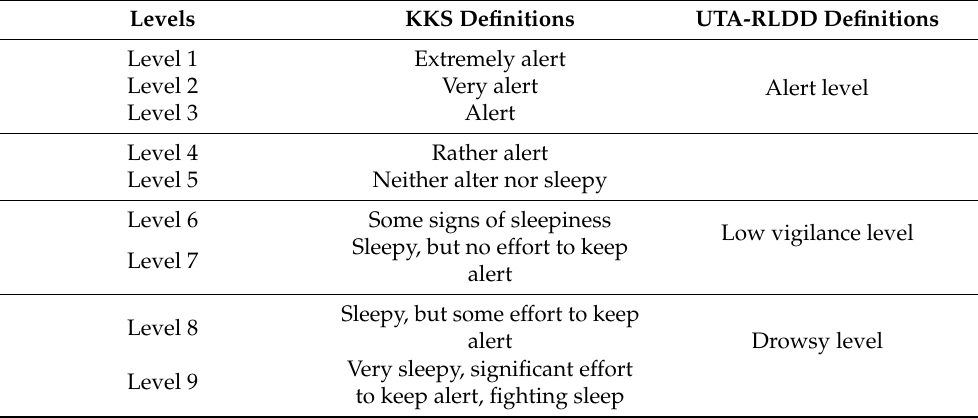
Table 1. The Karolinska sleepiness scale levels and the classification of UTA-RLDD.